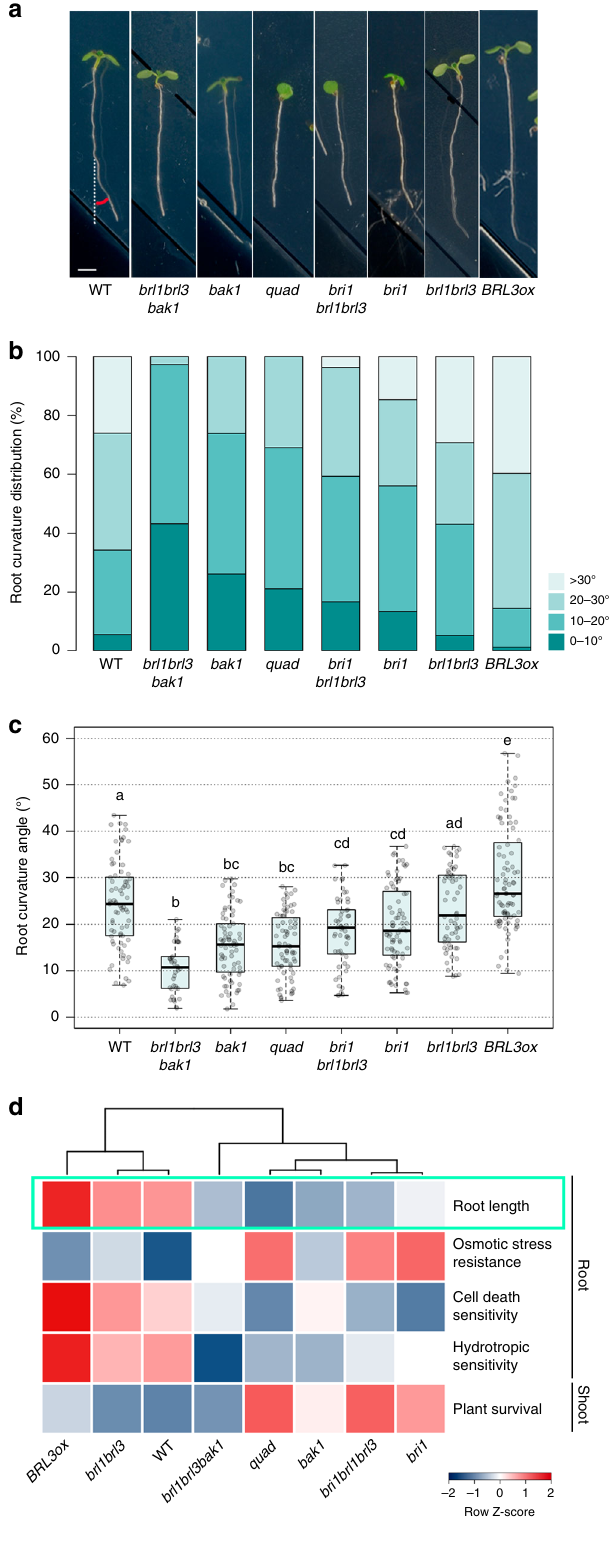
Fig. 2 Overexpression of the BRL3 receptor promotes root hydrotropism. a Root curvature (hydrotropic response) in 7-day-old roots after 24 h of sorbitol-induced osmotic stress (270 mM). Scale bar: 0.2 cm. b Discrete distribution of root hydrotropic curvature angles in the different genotypes. Lightest green depicts roots curved between 0° and 10°, light green between 10° and 20°, dark gray between 20° and 30°, and darkest green depicts roots that have a curvature of more than 30° . c Continuous distribution of root curvature angles. Different letters indicate a signi fi cant difference ( p -value < 0.05) in a one-way ANOVA test plus Tukey ’ s HSD test. Boxplot represent the median and interquartile range (IQR). Whiskers depict Q1 – 1.5*IQR and Q3 + 1.5*IQR and points experimental observations. Data from four independent biological replicates ( n > 50). d Stress traits matrix for all physiological assays performed on the roots and shoots of WT, BR loss-of-function mutants and BRL3ox . Root growth in control conditions is highlighted in green. Color bar depicts values for scaled